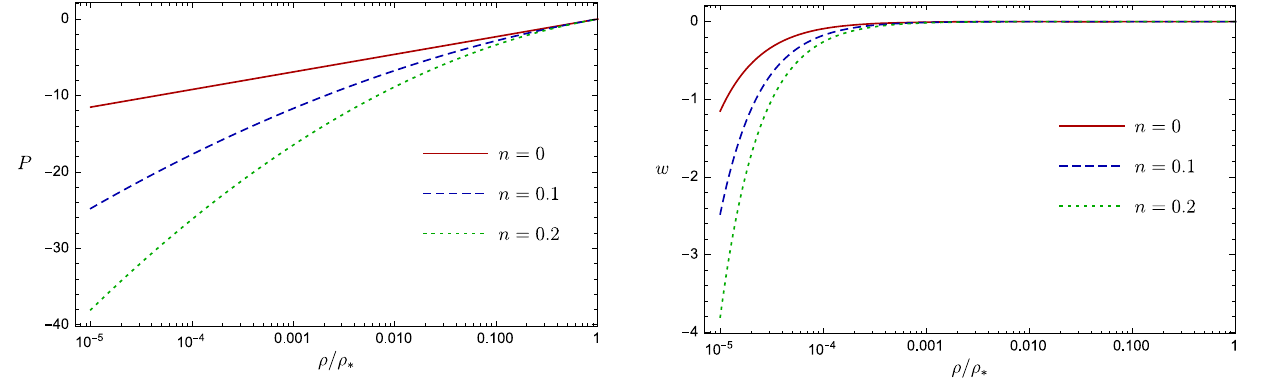
Fig. 1 Pressure as a function of the density in extended logotropic models (cf. Eq. (5)). The different curves correspond to different values of the parameter n , while we have assumed A = 1